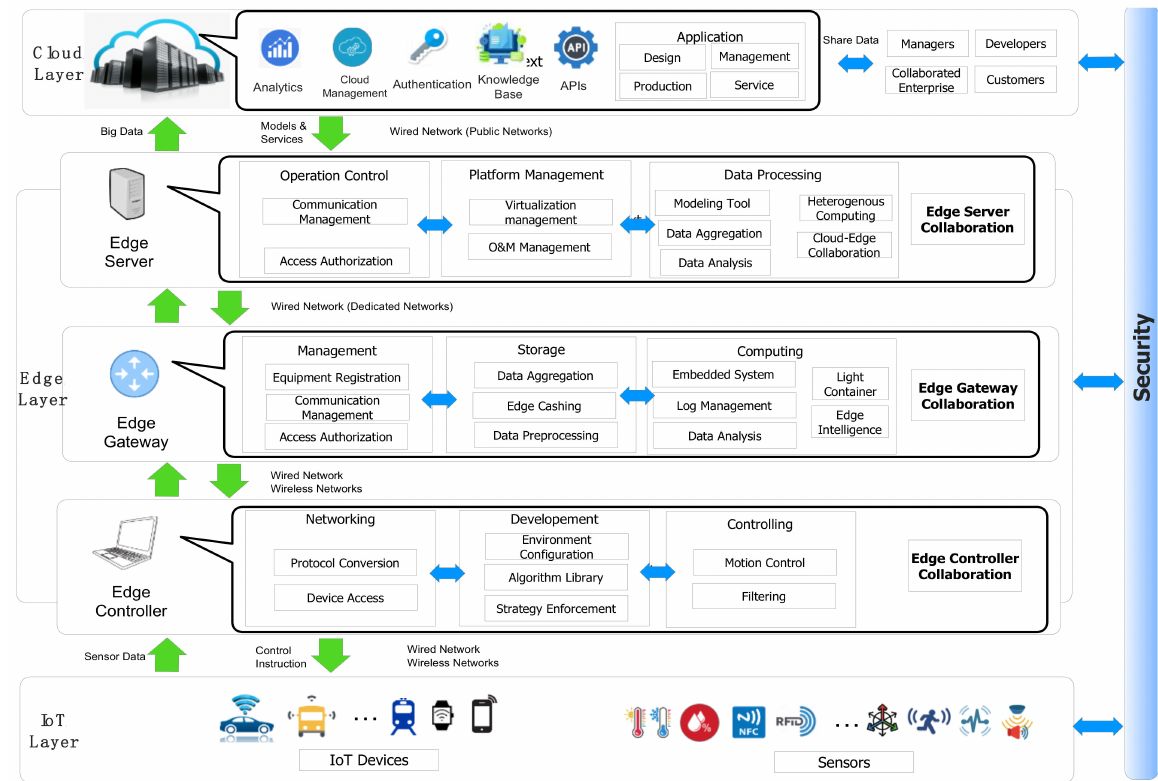
Figure 1. A secure architecture for edge computing-based